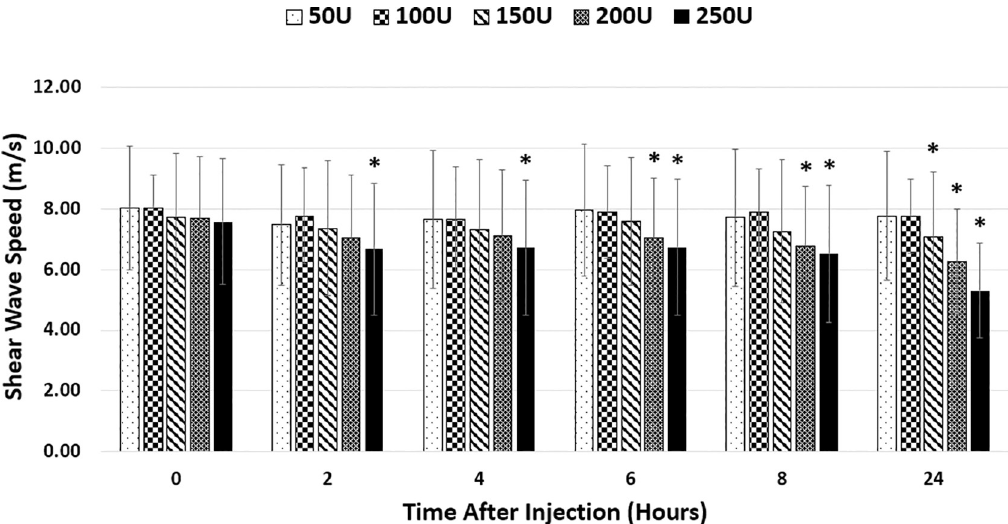
Fig 5. Shear wave speed results. Shear wave speed of individual doses at different timepoints. Significant change in shear wave speed from time 0 within dose signified by ( � ).